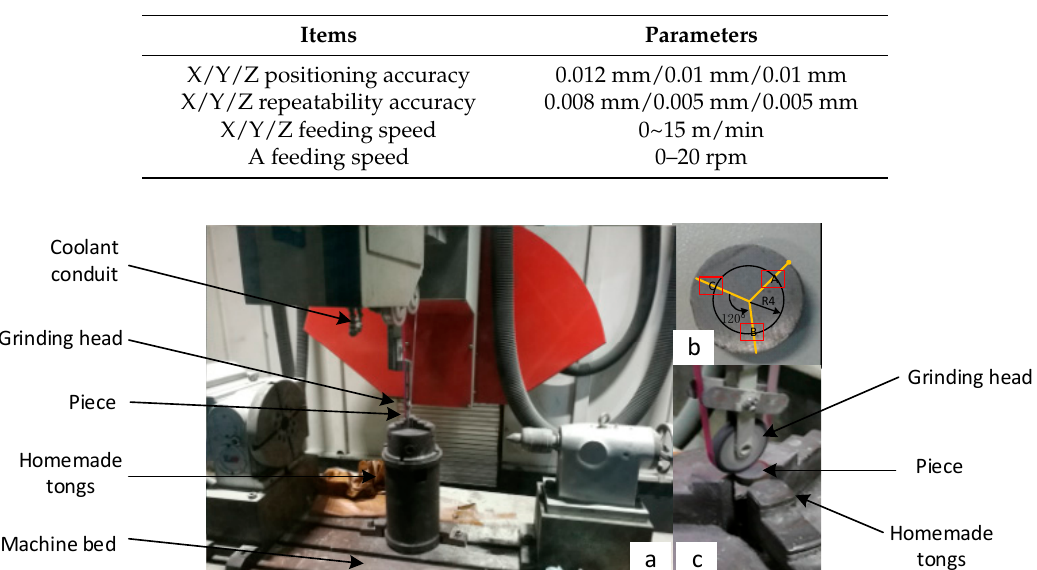
Table 1. Axis accuracy of the machining tool.